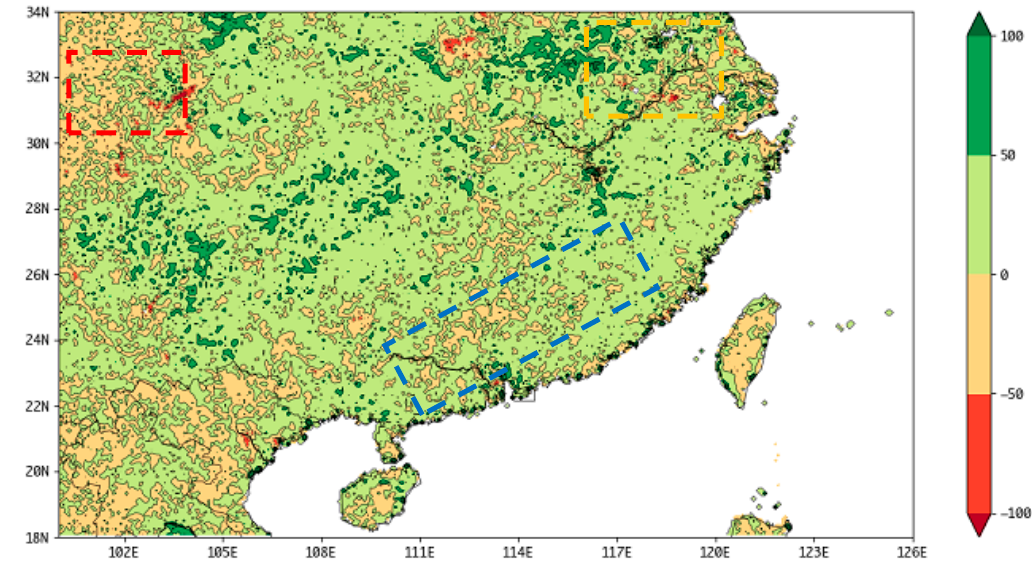
Figure 5. Trends of annual maximum NDVI over the period 1998–2014 (ndvi · year − 1 ).